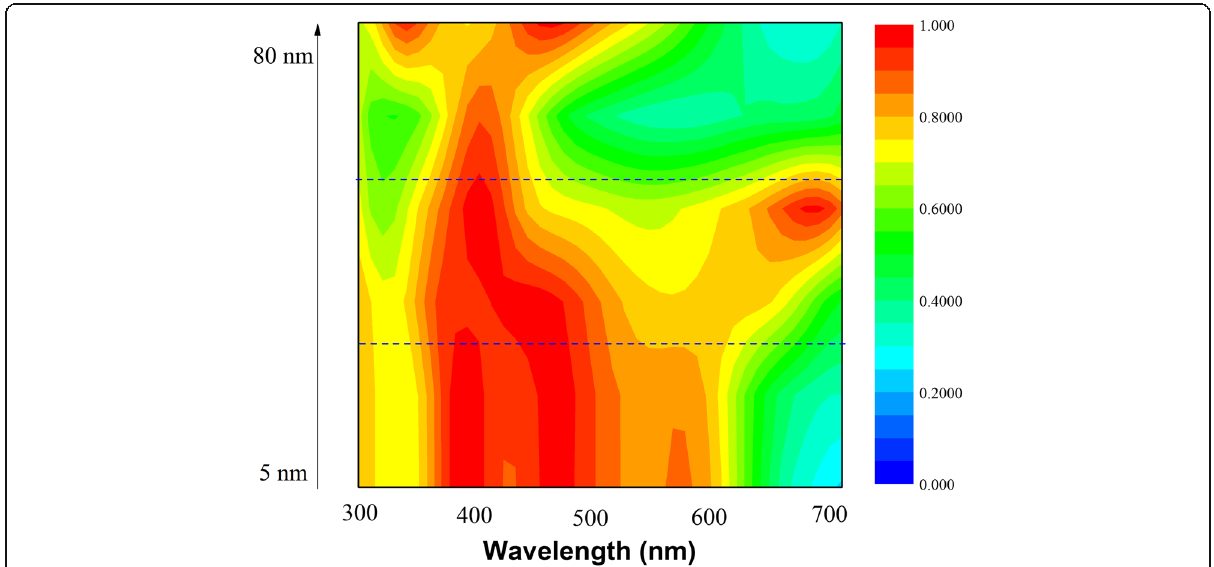
Fig. 6 Absorption color map of different-sized NPs in the homogeneous active layer with Al cathode contacted with the active